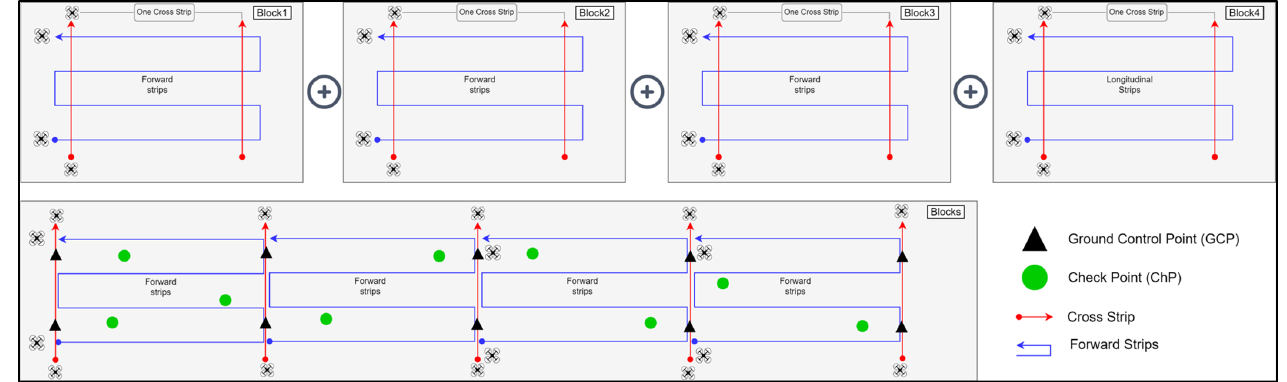
Figure 6. ( Upper row ) Study area distributed in four blocks. ( Bottom row ) Distribution of the flight lines for Scenario C.